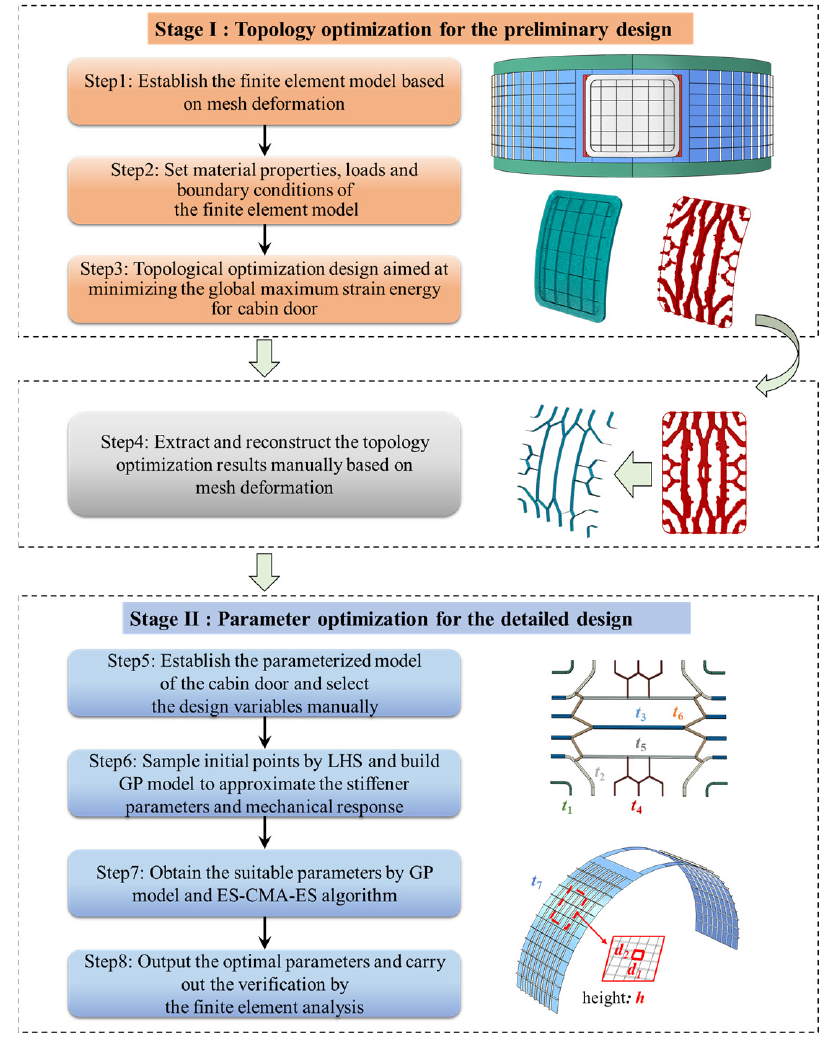
Figure 3. Flow chart of intelligent layout design framework for curved cabin door.